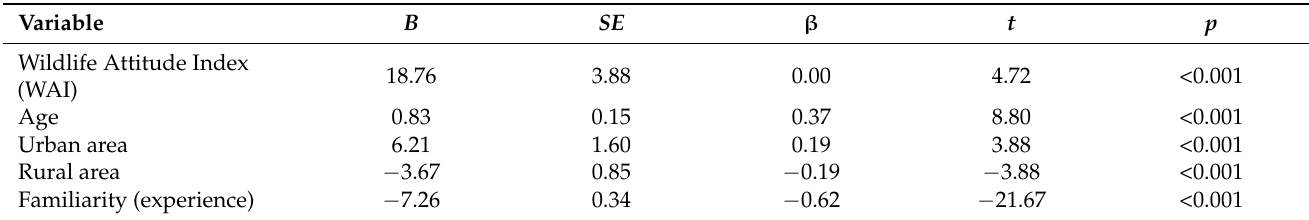
Table 5. Regression analysis of Wildlife Attitude Index (WAI).